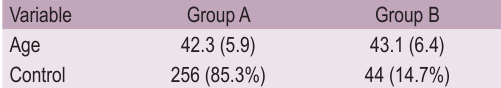
TABLE 1. Age characteristics of the sample